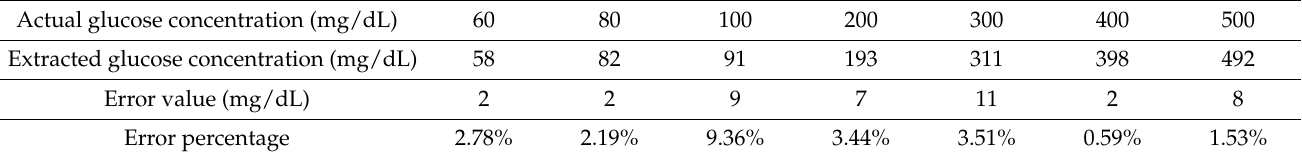
Table 3. Extraction errors for glucose concentration of tissue phantom solutions without albumin. Actual glucose concentration (mg/dL) Extracted glucose concentration (mg/dL)